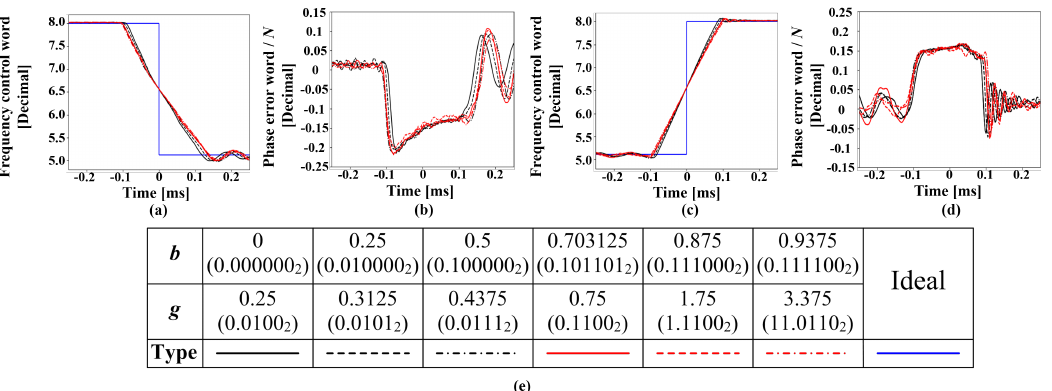
Figure 14. Measured step response with low-frequency open-loop gain fixed: ( a , b ) frequency control code and detected phase error code for falling input frequency step, ( c , d ) those for rising input frequency step, ( e ) the legend for each parameter. The timing in code variations is shifted so as to have the same 50% transition point of the frequency control code. The frequency control code is also shifted up to match the DCO input